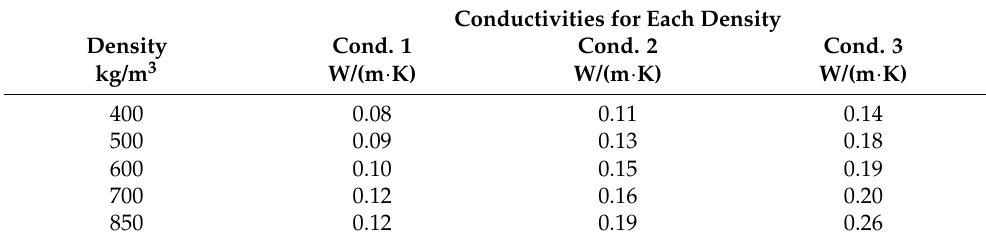
Table A3. Thermal properties of wood used for the simulation. For all cases, the specific heat considered was 1600 J/(kg ·